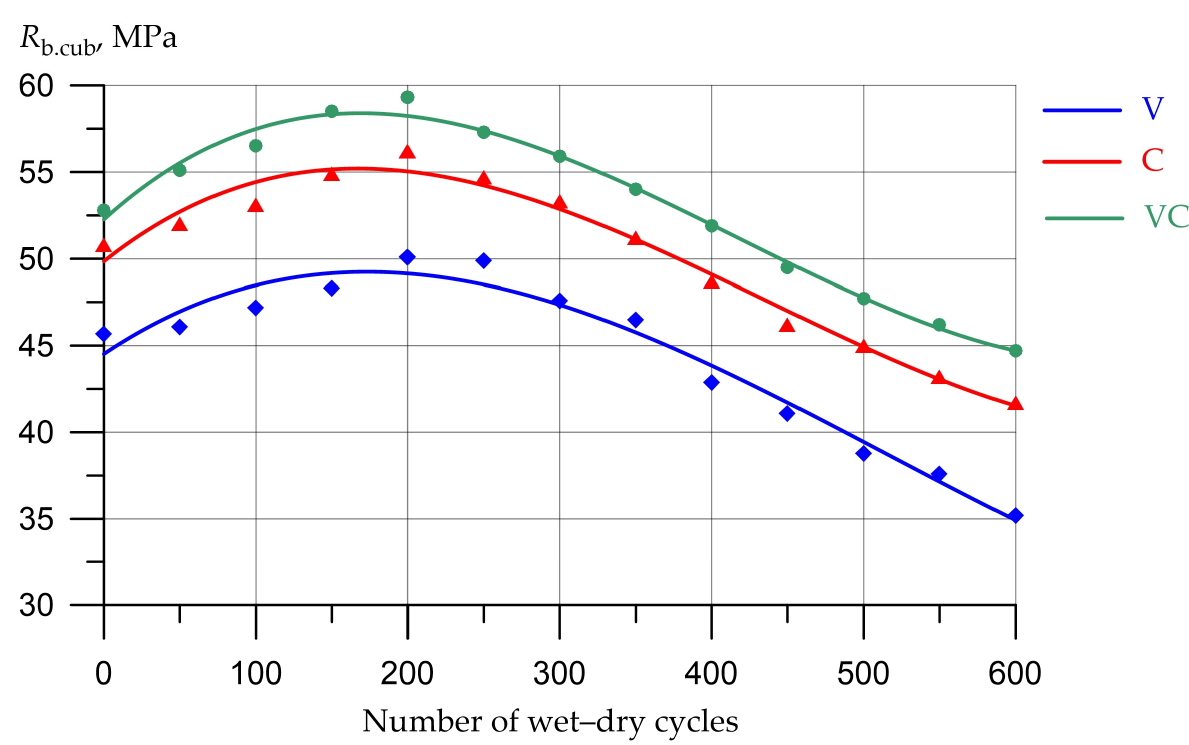
Figure 10. Dependence of the change in the cubic compressive strength of vibrated, centrifuged, and vibrocentrifuged concretes on the number of moistening and drying cycles at pH 10.